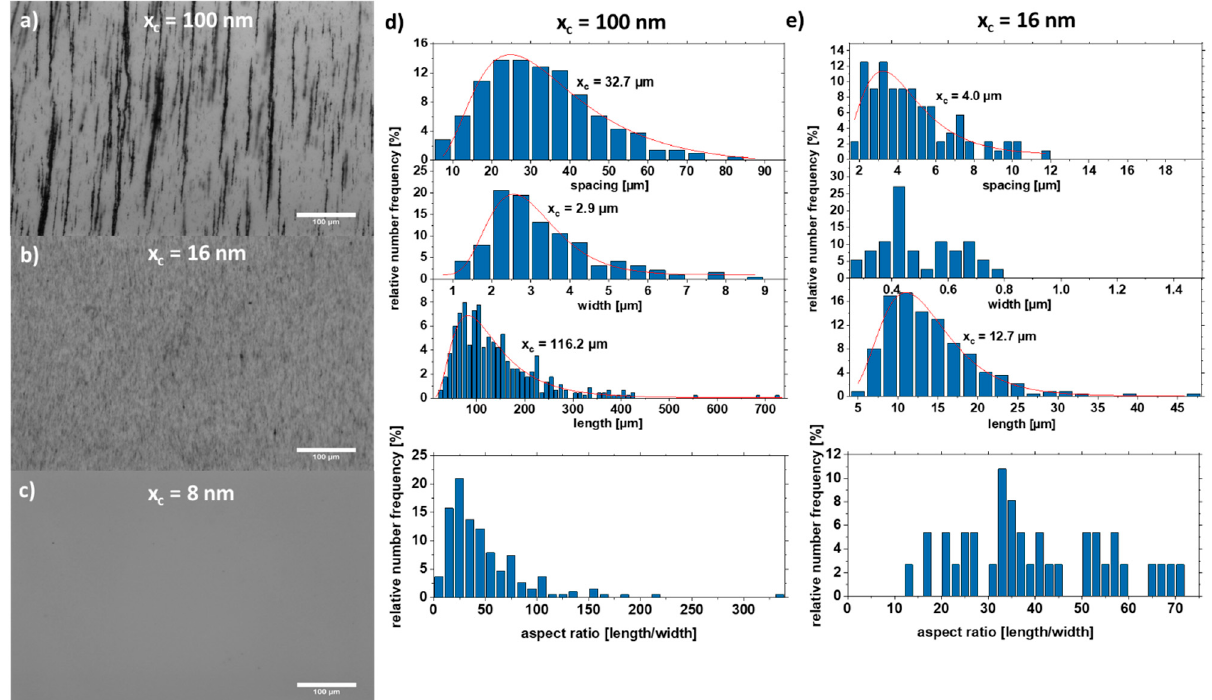
Figure 5. Optical microscopy images of strands in 5% PMMA solution with particle sizes ( a ) x c = 100 nm, ( b ) x c = 16 nm, and ( c ) x c = 8 nm. The length, width, spacing, and the aspect ratio of the respective strands are shown for ( d ) x c = 100 nm and ( e ) x c = 16 nm.